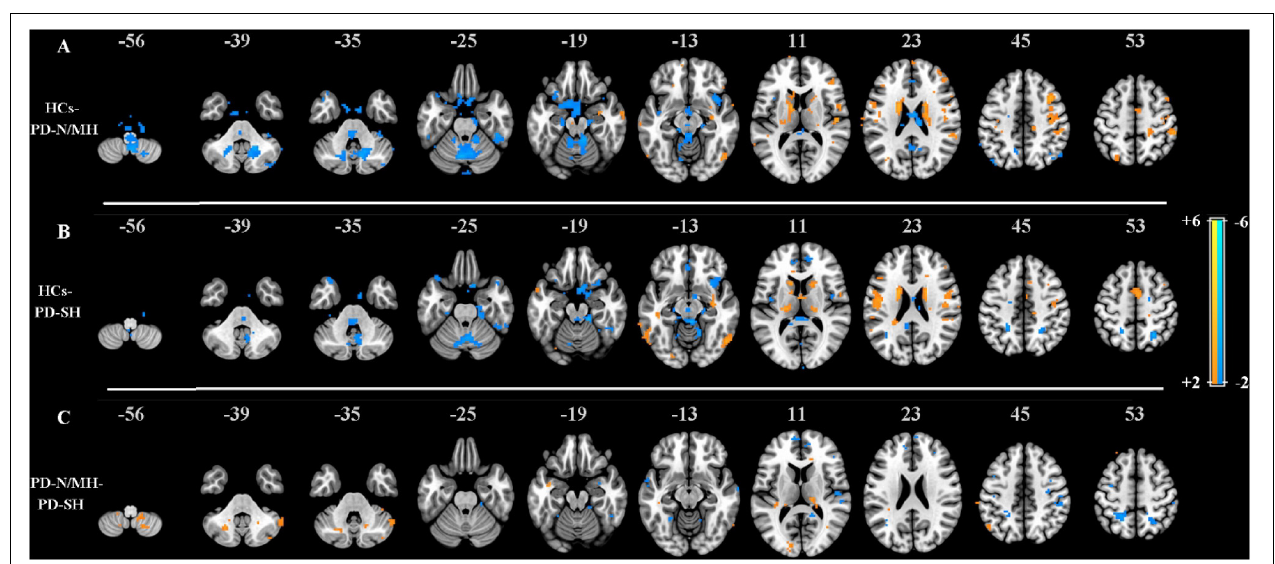
FIGURE 6 | One-sample t -test SCM maps separately derived from three sessions in the test-retest resting-state dataset ( n = 25, t > 3.0, p < 0.001, FDR corrected).